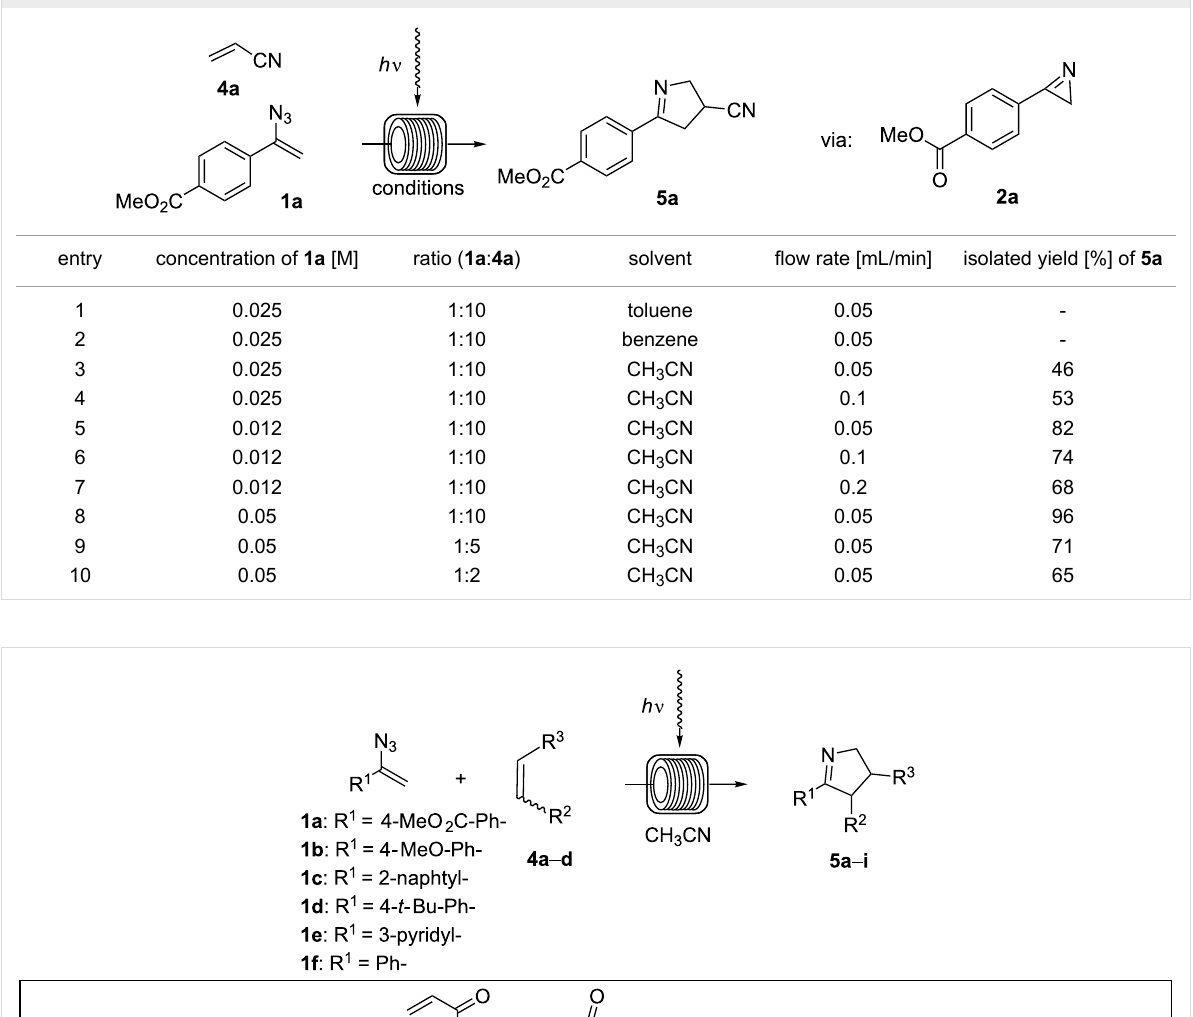
Table 2: Optimization of the photolysis of vinyl azide 1a and trapping of nitrile ylide with acrylonitrile 4a under flow